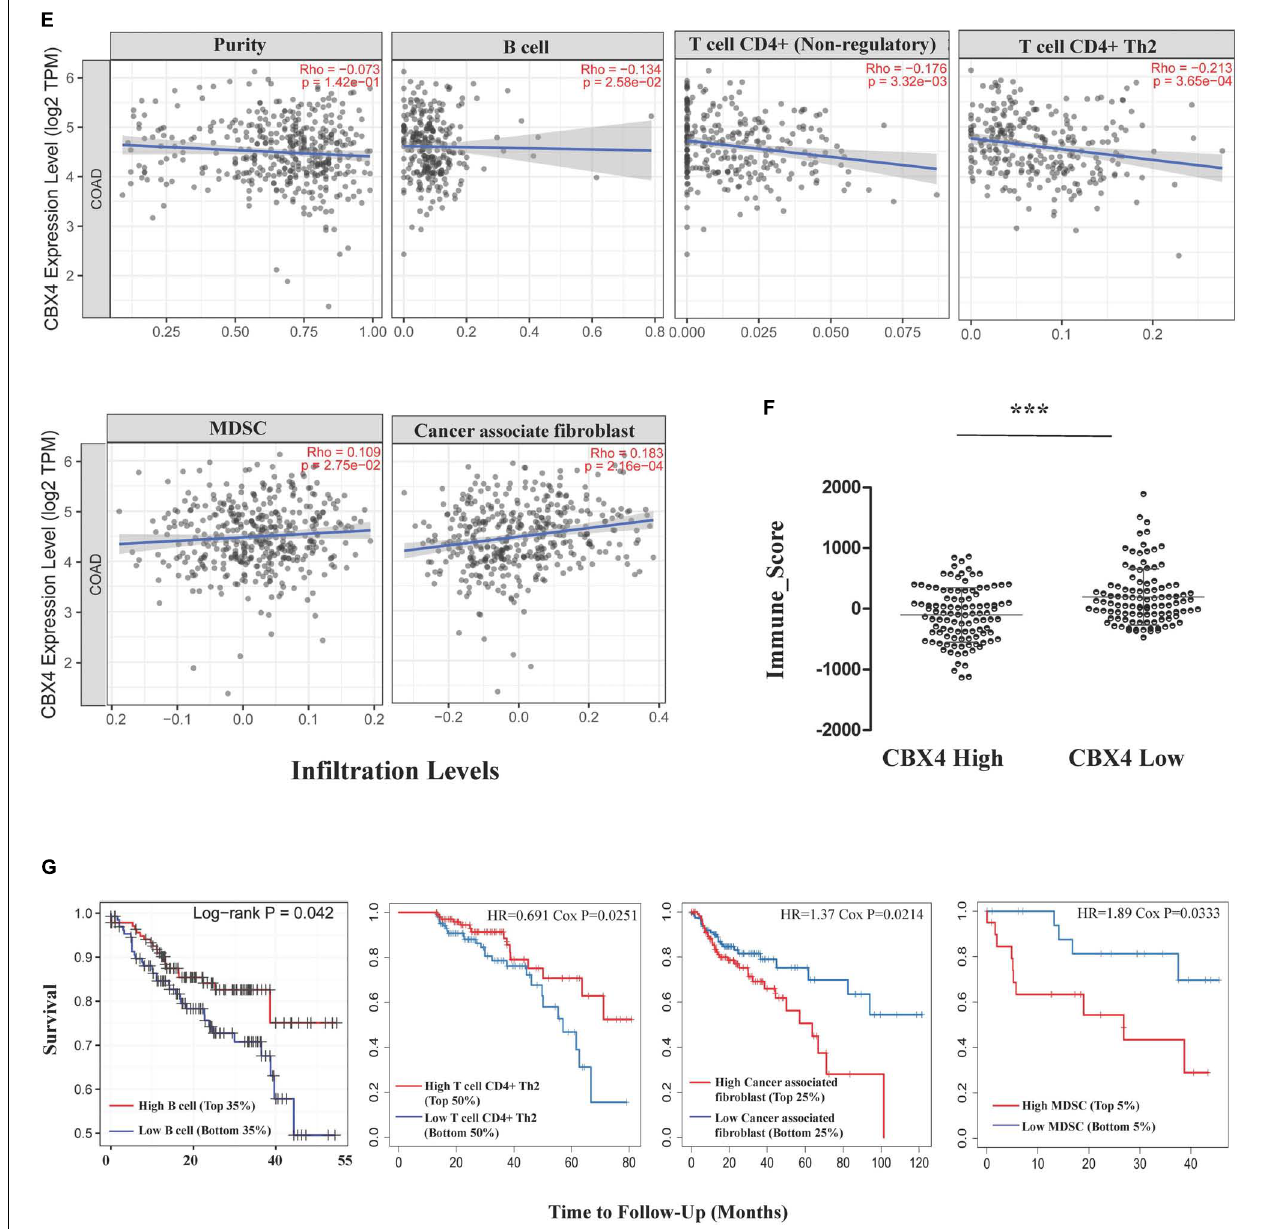
FIGURE 4 | CBX4 Impacts Immunophenotype in Colon Cancer. Correlations between CBX4 expression and the infiltration abundance of B cells (A) , CD4 + T cells (B) , myeloid derived suppressor cells (MDSCs) (C) and cancer associated fibroblast (CAFs) (D) were assessed in the 40 cancer types from the Gene module of TIMER2.0. The heat maps integrated multiple algorithms for immune infiltration estimation and showed the purity-adjusted partial spearman’s rho across various cancer types. Positive correlations (rho > 0) are red and negative correlations (rho < 0) are blue. The significance of these correlations was classified into P < 0.05, shown in solid squares and P > 0.05, shown in hollow squares. (E) In COAD ( n = 458), scatter plots showed the relationship between CBX4 expression in log2 TPM and levels of tumor purity, infiltrating B cells, CD4 + T cells, MDSCs, and CAFs. Spearman’s rho and statistical significance were shown. (F) The immune score of ESTIMATE algorithm representing the overall infiltration levels of the immune cells in COAD. 210 of TCGA samples were divided into two groups based on the FPKM levels of CBX4. The immune scores for these samples were collected from the RNAseq V2 platform of the ESTIMATE database, and analyzed based on the dichotomized cases with high and low expression of CBX4. * P < 0.05, ** P < 0.01, *** P < 0.001 (G) Influences of the above immune infiltrating subsets on the clinical outcome of COAD were evaluated by the Survival module of TIMER. The Kaplan-Meier plots visualized the survival differences between the high and low infiltration levels of B cells, CD4 + Th2 cells, MDSCs and CAFs. The hazard ratio and p value for Cox model and the log-rank p value for Kaplan-Meier curve were shown.